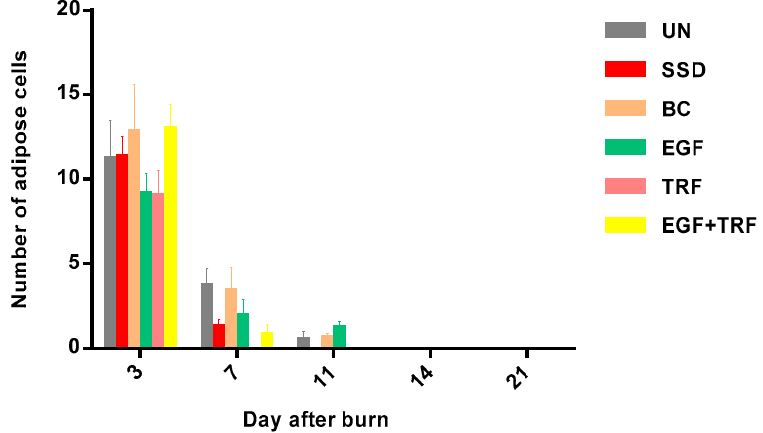
Figure 3. Number of adipose cells in all the groups over time post-burn. Note: Values calculated over a 21-day trial and expressed as mean ± S.E.M. for six rats.